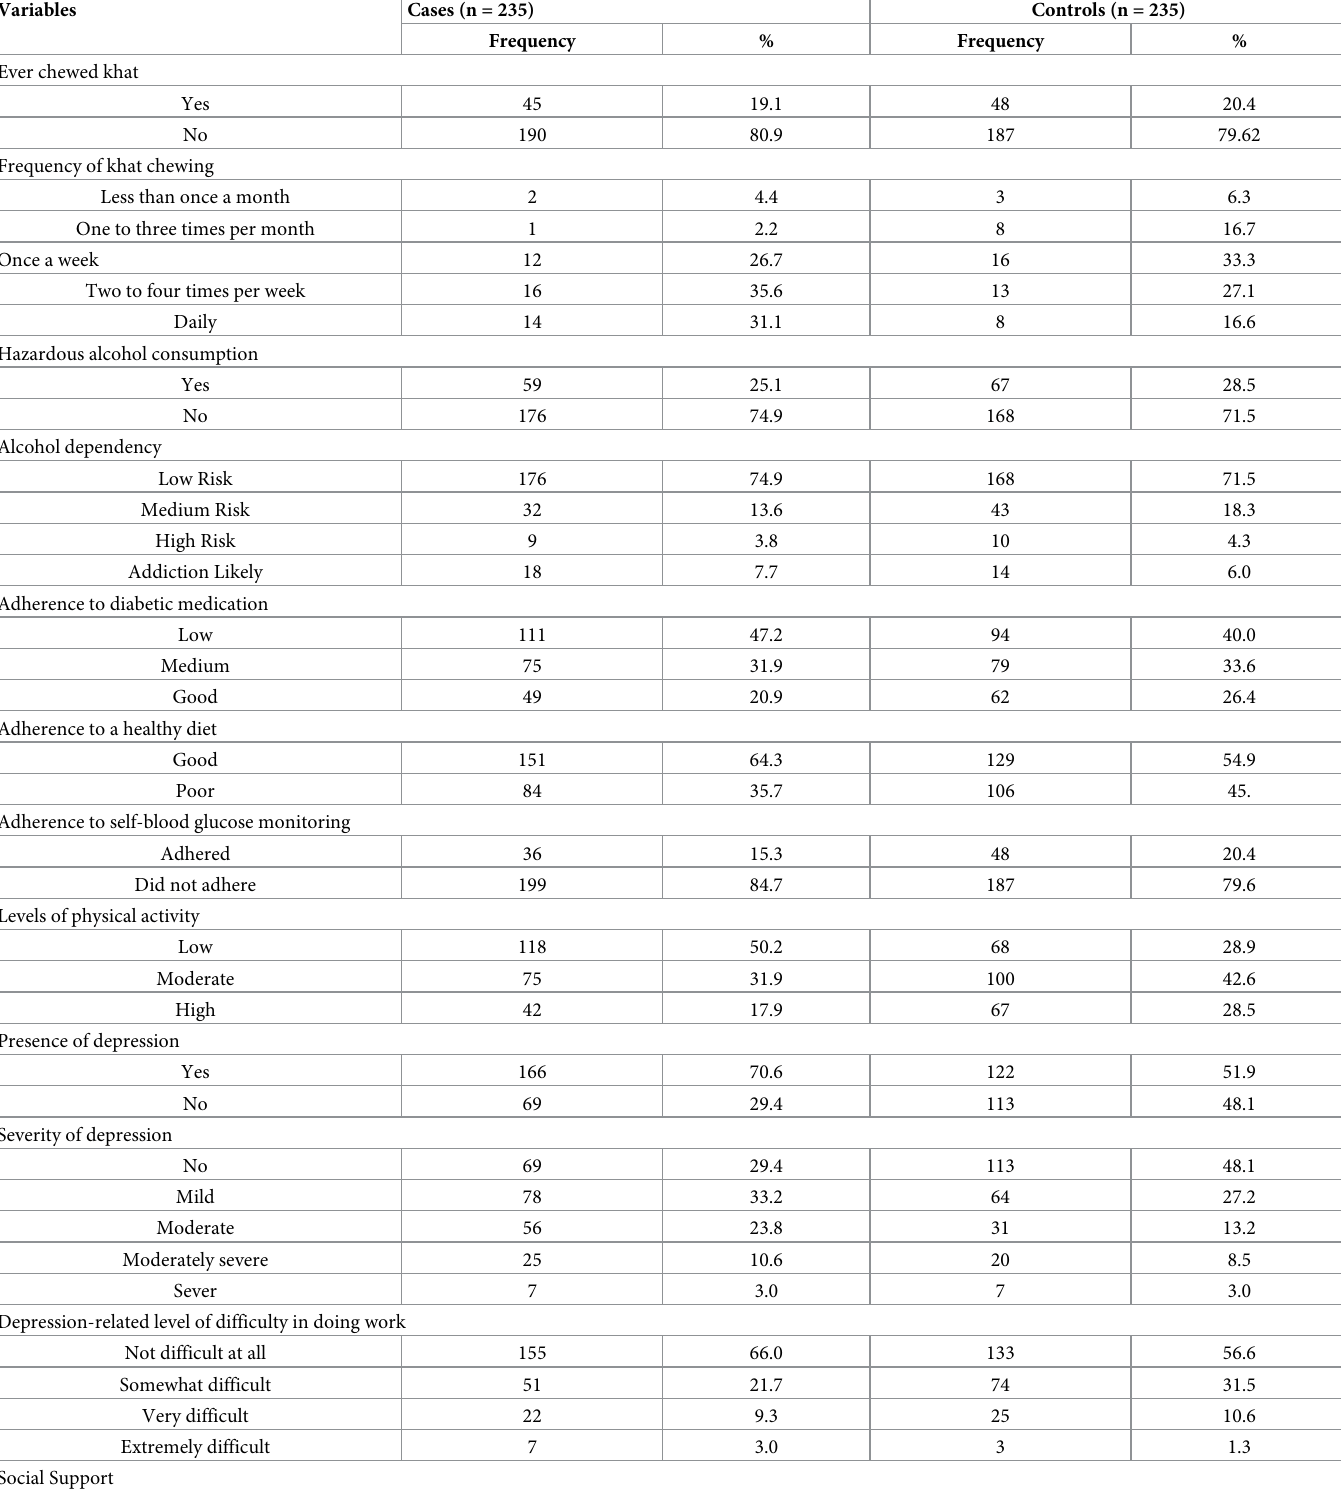
Table 2. Psychosocial and behavioural characteristics of study